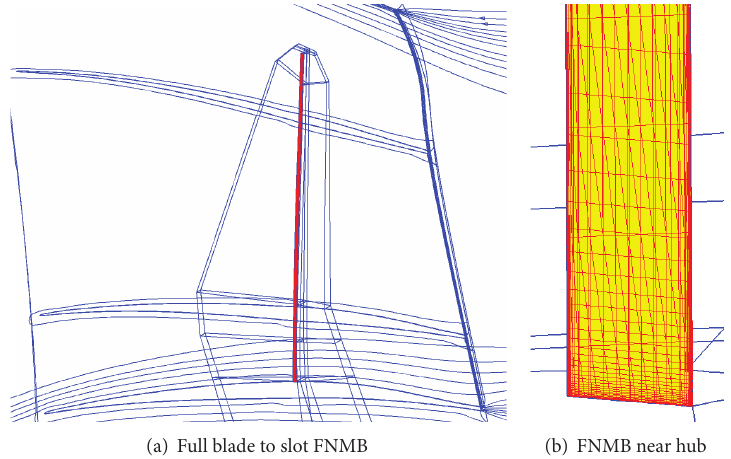
F 6: Main passage grid on the rotor two suction